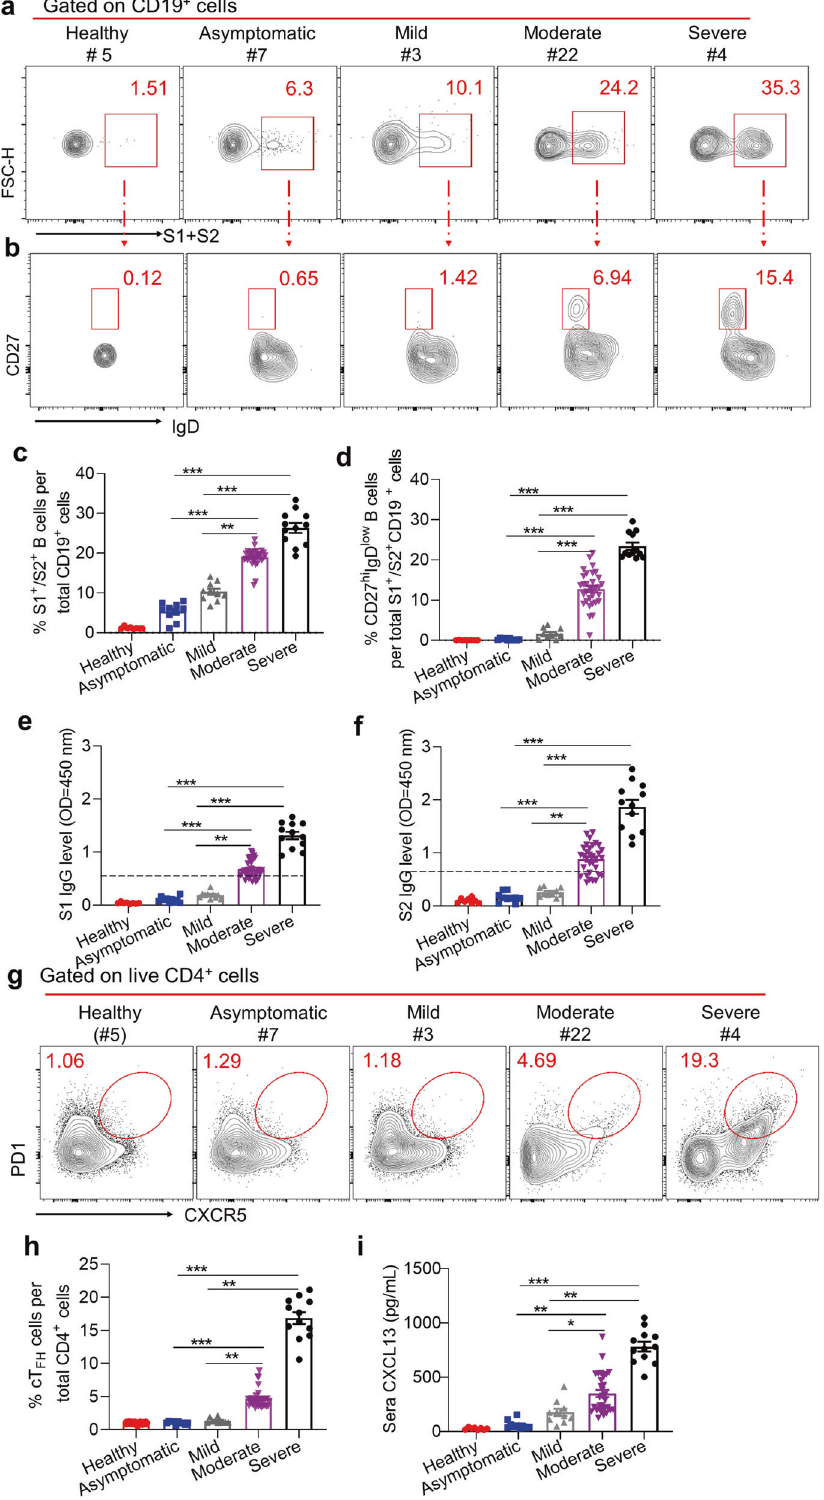
Fig. 1 Virus-speci fi c B cell responses to SARS-CoV2 in COVID-19 patients with different severity. Samples of a , b and g were from Healthy (#5), Asymptomatic (#7), Mild (#3), Moderate (#22), Severe (#4). a FACS plot examples of SARS-CoV2 S1- or S2- speci fi c B cells (S1 + /S2 + CD19 + ) of live lymphocytes in PBMCs. b FACS plot examples of SARS-CoV2 S1- or S2- speci fi c memory B cells (CD27 hi IgD low ), gated on S1 or S2 speci fi c B cells (S1 + /S2 + CD19 + ) shown in ( a ). c , d Percentages of S1 or S2 speci fi c B cells ( c ), summarized from ( a ); and S1 or S2 speci fi c memory B cells ( d ), summarized from ( b ), in COVID-19 recovered patients with different disease severity. e , f ELISA analysis of S1- and S2- speci fi c IgG levels in convalescent-phase COVID-19 patients ’ sera with various groups. Dilution of 1:100 was used for serum samples. g FACS plot examples of cT FH (PD1 hi CXCR5 hi ), gated on live CD4 + T cells. h The summarization of percentages of cT FH from ( g ). i CXCL13 protein level in convalescent-phase COVID-19 patients ’ serum with various groups, measured by ELISA. Bars represent the mean ± SEM. P values were calculated based